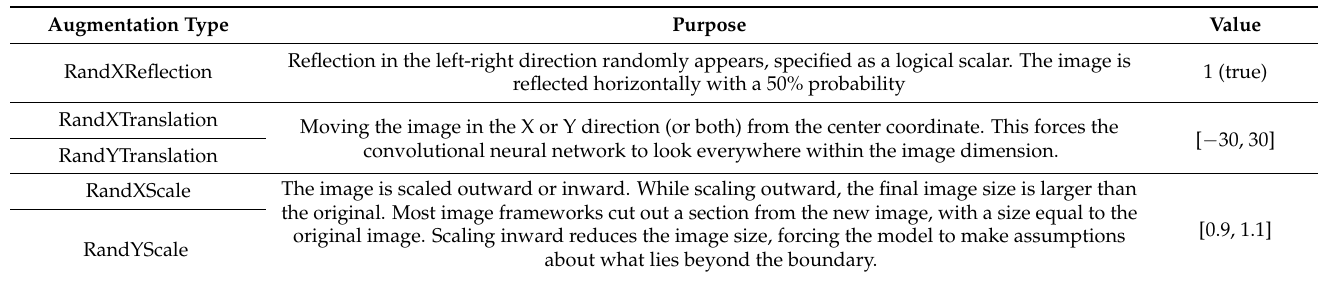
Table 4. Image Augmentation Parameters.